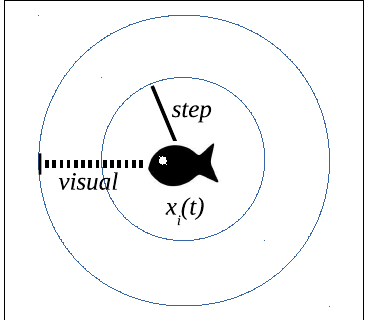
Figure 3. Currently the fish i is at the position x i ( t ) . From this position, it can see other fish if they are in the area defined by the parameter “visual”. The parameter “step” defines the radius of the area that limits the movement of this fish when it